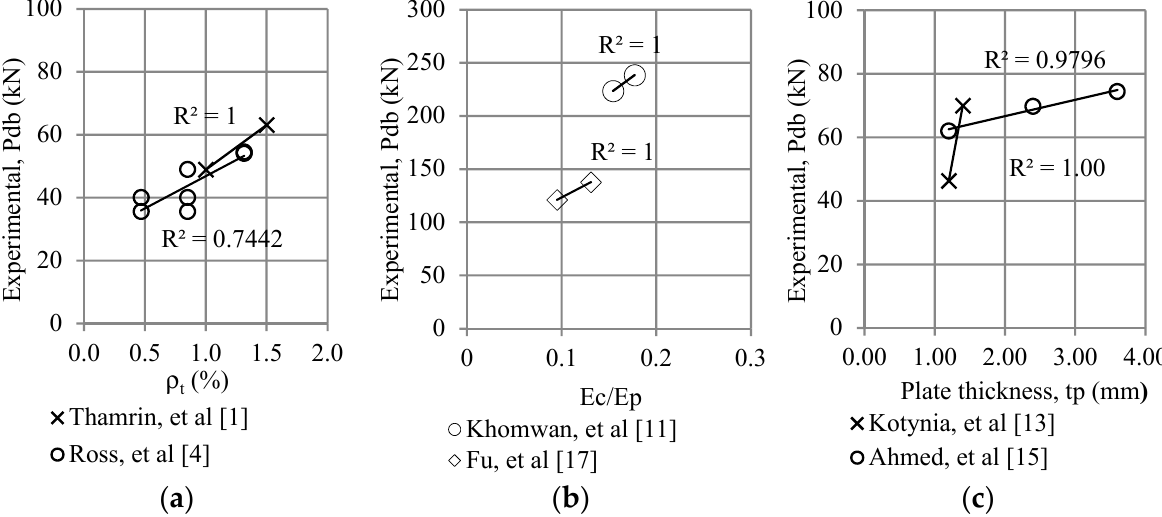
Figure 16. Effect of ( a ) ratio of tensile reinforcement, ( b ) E c / E p , and ( c ) the plate thickness on the debonding loads.